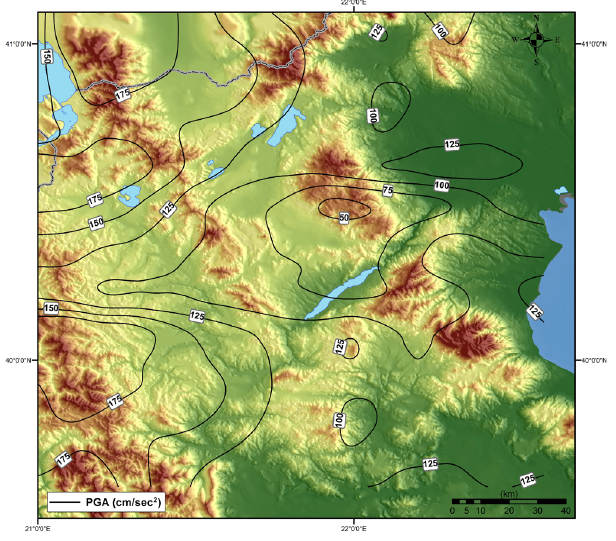
Fig. 3. Peak ground acceleration (cms − 2 ) with probability 90% of not being exceeded in 50yr (Return Period = 475yr) for the period 1900–1973.